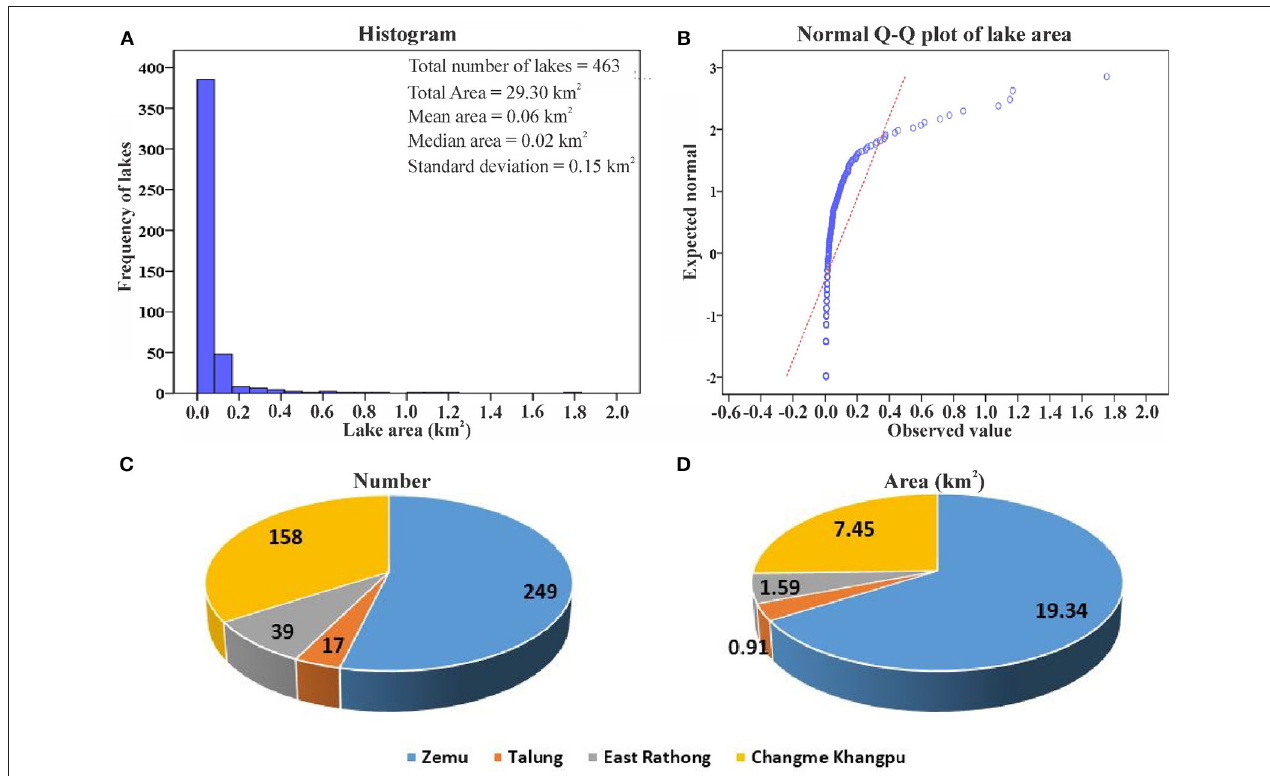
FIGURE 5 | Distribution of lake area (2000) in different basins. (A) Frequency distribution table. Note the maximum proportion of small lakes having area < 0.01 km 2 . (B) Normal Q-Q plot of lake area using Shapiro-Wilk distribution test. Panels (C,D) show the distribution of number and area of lakes in different basin of the Sikkim Himalaya, respectively.